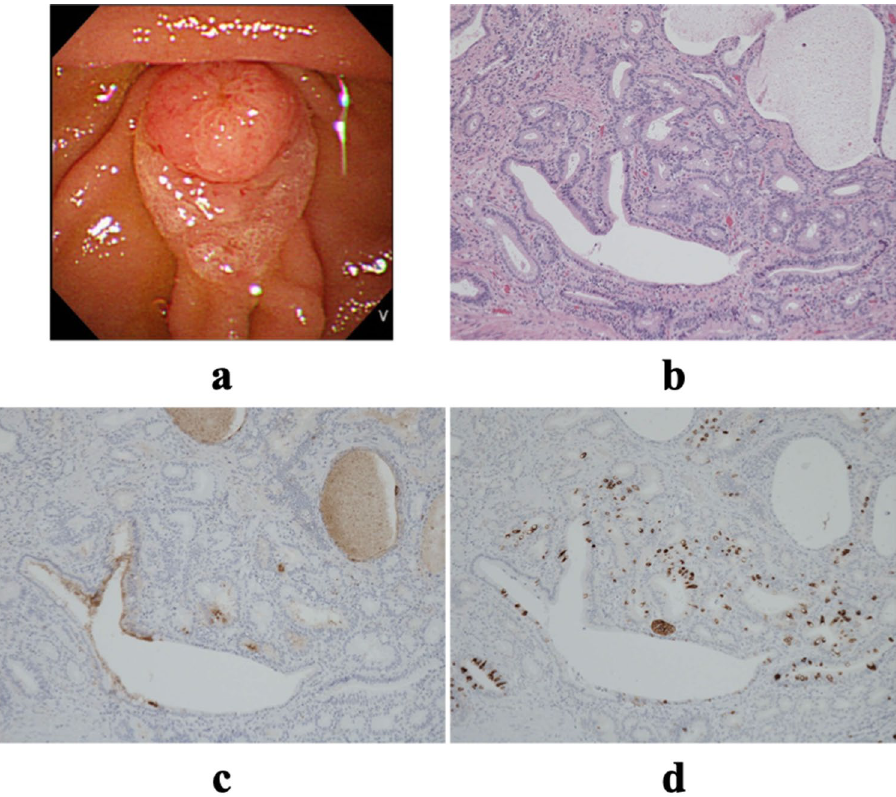
Figure 5. Characteristics of mixed-type tumors. ( a ) Endoscopic image. ( b ) Hematoxylin–eosin staining of the tumor (× 40). ( c ) MUC1 expression in the tumor (× 40). ( d ) MUC2 expression in the tumor (× 40). MUC1, pancreatic-type mucin; MUC2, intestinal-type